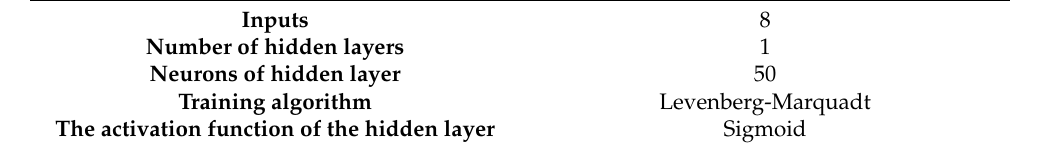
Figure 6. Structure of neural network. Table 4. Features of neural